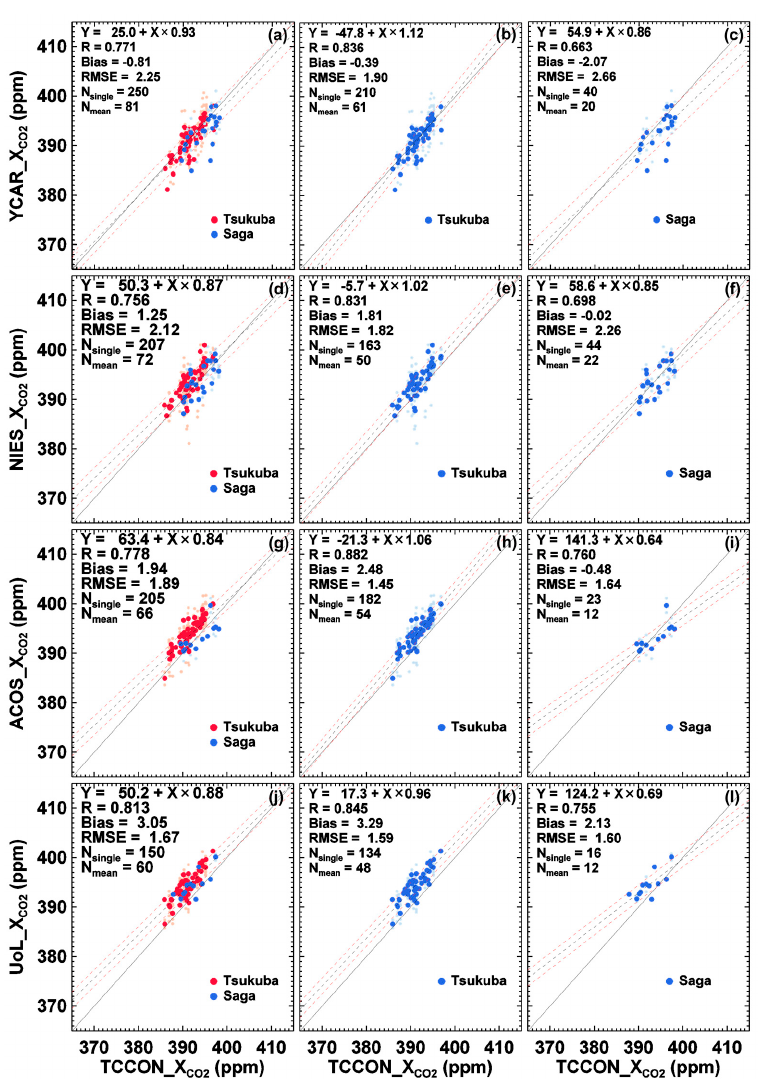
Figure 4. Comparison of retrieved X CO2 from four GOSAT algorithms (( a – c ) YCAR-CAI; ( d – f ) NIES; ( g – i ) ACOS; and ( j – l ) UoL) with TCCON X CO2 for two TCCON sites: Tsukuba (middle), Saga (right), and both (left). All individual sounding GOSAT data are shown as small faded dots, and daily average values are shown as large distinct colored dots. Black dotted line is the best-fit line calculated from robust fitting and red dotted lines are RMSE range of best-fit line. The solid line is linear identity function.